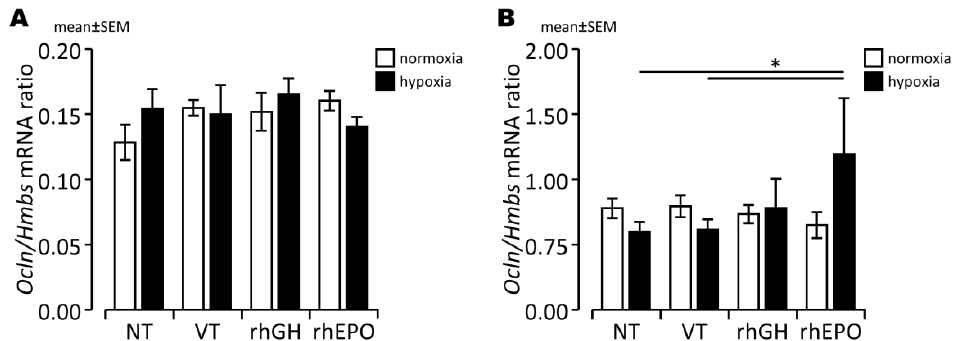
Figure 3. Gene expression of Ocln relative to PBGD in normoxic and hypoxic brains of neonatal mice with and without rhGH and rhEPO treatment after a regeneration period of 48 h ( A ) or 7 d ( B ). *, p < 0.05.